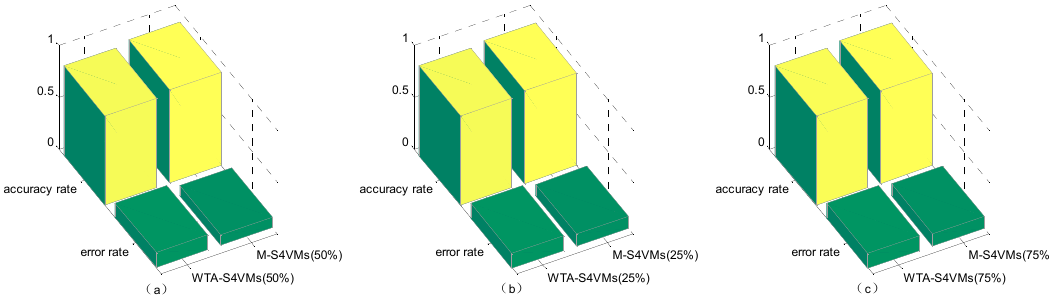
Note: accuracy1 represents the accuracy of the first classification without unlabeled samples, and accuracy2 represents the accuracy of M-S4VMs with unlabeled samples.